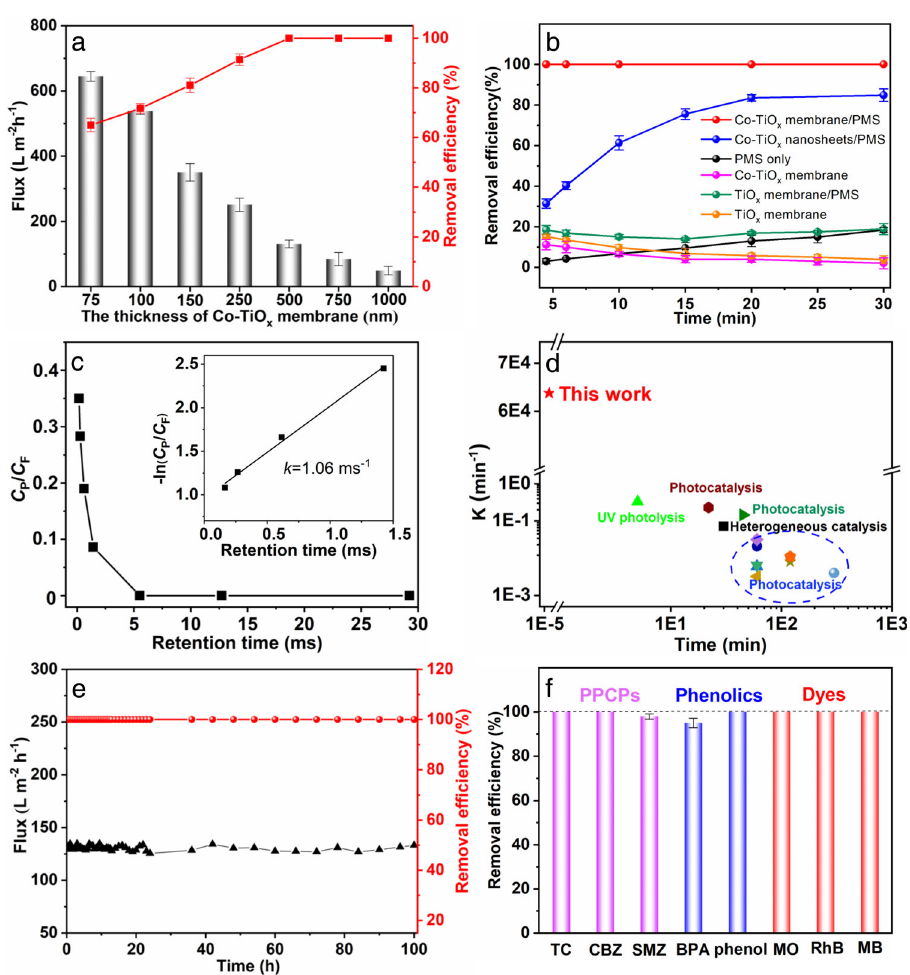
Fig. 3 Angstrom-con fi nement catalysis performance of the Co-TiO x membrane. a Permeance of Co-TiO x membranes and ef fi ciency of ranitidine removal as a function of membrane thickness. b Removal ef fi ciency of ranitidine in different reaction systems. c Normalized concentration of ranitidine ( C permeate / C fi rst-order kinetics. d Comparison of the fi rst-order rate constant k values. e Stability test of feed ) versus membrane retention time. The inset showing the fl ux and removal ef fi ciency with operation duration. f Removal ef fi ciencies of PPCPs, phenolics, and dyes. Conditions of the feed solution for all